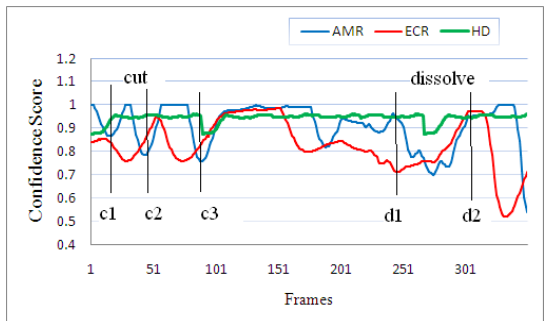
Fig. 10 Comparison of AMR with ECR and HD in detecting cut and dissolve